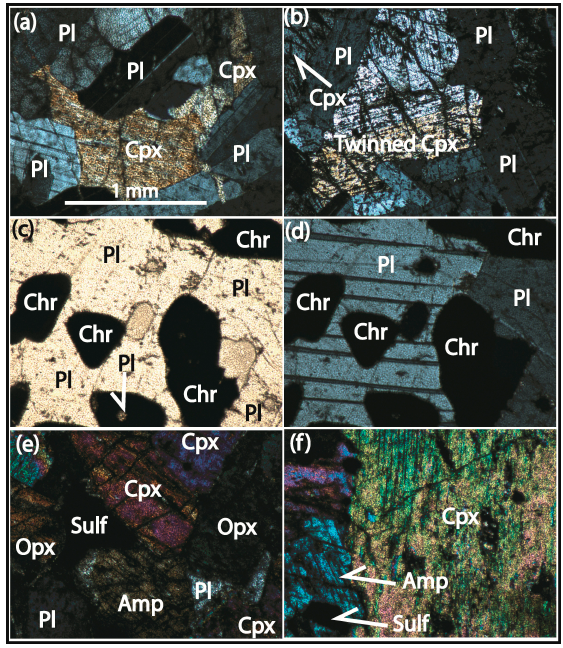
Figure 5. Scale bar shown in ( a ) is the same for all photomicrographs. ( a ) Photomicrograph showing polysynthetically twinned plagioclase (Pl) occurring association with clinopyroxene (Cpx). The clinopyroxene is altered, and is interstitial to plagioclase crystals (crossed polars, sample MusGa02). In ( b ), from the same thin section, a clinopyroxene crystal occurring just to the left of center shows twinning. In addition to clinopyroxene, plagioclase is the only other mineral shown (crossed polars). In the sample with the chromitite stringer (Sample MusCR01), minute fine- to medium-grained euhedral to subhedral chromite crystals occur enclosed within poikilitic plagioclase crystals (( c ), plane polarized light and ( d ), crossed polars). Some of the chromite crystals occur at the intersection of differently oriented plagioclase crystals. Cumulus and altered clinopyroxene and orthopyroxene (Opx) occur together with intercumulus sulfides (Sulf) in sample MusWebb01a ( e , f ), crosses polars). Plagioclase occurs an intercumulus phase ( e ), whereas amphibole (Amp) with characteristic cleavage can be seen occurring adjacent to clinopyroxene, with sulfides occurring as inclusions within crystals of amphibole ( f ). Within the chromitite stringer (sample MusCR01), occurring stratigraphically below the gabbronorite sample, minute fine- to relatively coarser-grained euhedral to subhedral chromite crystals typically occur wholly enclosed within poikilitic plagioclase crystals (Figure 5c,d). However, some of the fine-grained chromite crystals in this sample also occur at the intersection of differently oriented plagioclase crystals (Figures 5c,d). Occurring stratigraphically below the chromitite stringer in plagioclase websterite are cumulus and altered clinopyroxene and orthopyroxene crystals together with intercumulus sulfide crystals (Figure 5e,f; sample MusWebb01a). In the plagioclase websterite, plagioclase crystals tend to occur as intercumulus phases but amphibole, with characteristic cleavage (Figure 5f), also occurs together with clinopyroxene. Very fine-grained sulfide crystals in this sample occur as inclusions within very coarse-grained amphibole crystals (Figure 5f). Numerous alteration minerals such as chlorite and